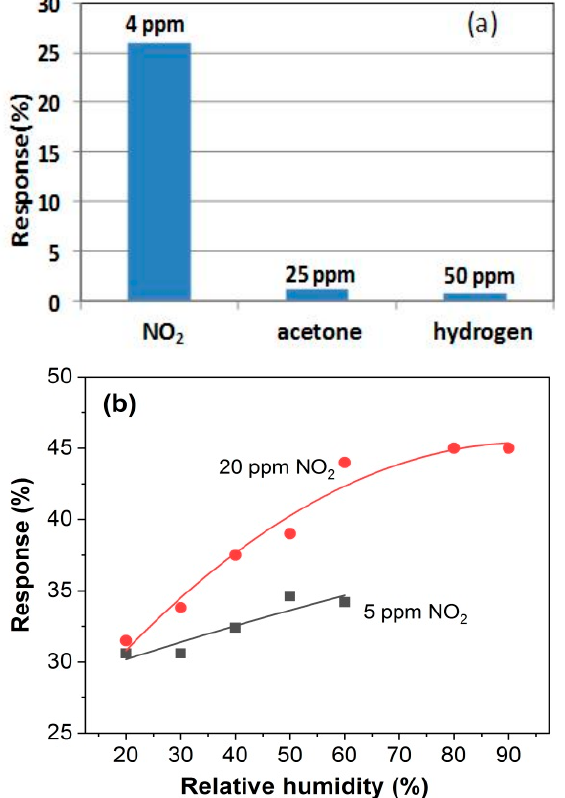
Figure 7. ( a ) The response of GO/Fe 2 O 3 6LbL structure to different gases at room temperature and ( b ) variation of this response with the change of relative humidity at 90 ◦ C.